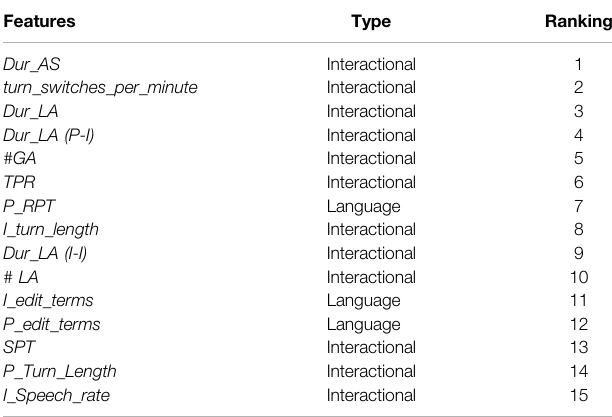
TABLE 8 | Top 15 ranked features including dis fl uency and interactional features by RFE.